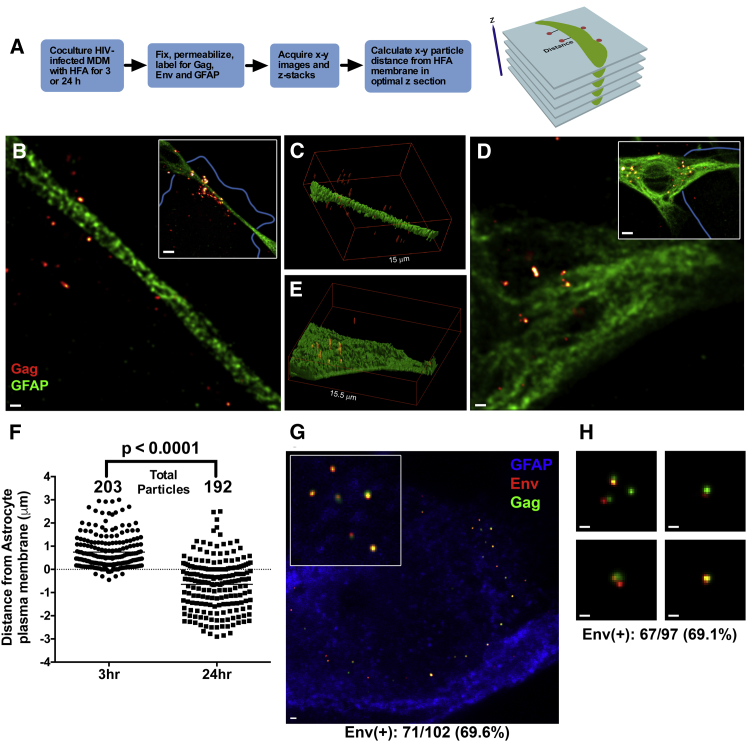
STED Analysis of HIV-1 Transfer from MDMs to HFAs(A) Experimental chart and approach for measurement of virion-membrane distances.(B) Coculture of HIV-1BaL-infected MDMs with HFAs (GFAP, green) for 3 hr, with virions released from the MDMs labeled in red. Inset shows a low-magnification image, with MDMs outlined in blue. Scale bar, 500 nm; inset scale bar, 3 μm.(C) 3D z projection of x-y sections through HFAs showing loss of resolution in the z plane.(D) Coculture of HIV-1BaL-infected MDMs with HFAs (GFAP, green) for 24 hr, with virions released from the MDMs in orange. Inset shows a low-magnification image, with MDMs outlined in blue. Scale bar, 500 nm; inset scale bar, 3 μm.(E) 3D z projection of x-y sections through HFAs showing loss of resolution in the z plane.(F) Distance of individual HIV-1 particles from HFA plasma membrane at 3 and 24 hr post-MDM-HFA coculture. Dotted line represents membrane, black line is mean, and p < 0.0001, determined by Student’s t test. Data are from two independent experiments using two MDM donors.(G) 3D z projection of Env/Gag-labeled HIV-1 particles associated with an HFA after 24 hr coculture with infected MDMs, of which >50% are internalized into HFAs. Scale bar, 500 nm; inset scale bar, 200 nm.(H) Representative images of Gag/Env-labeled HIV-1 particles adhered to a coverslip. Scale bar, 200 nm.